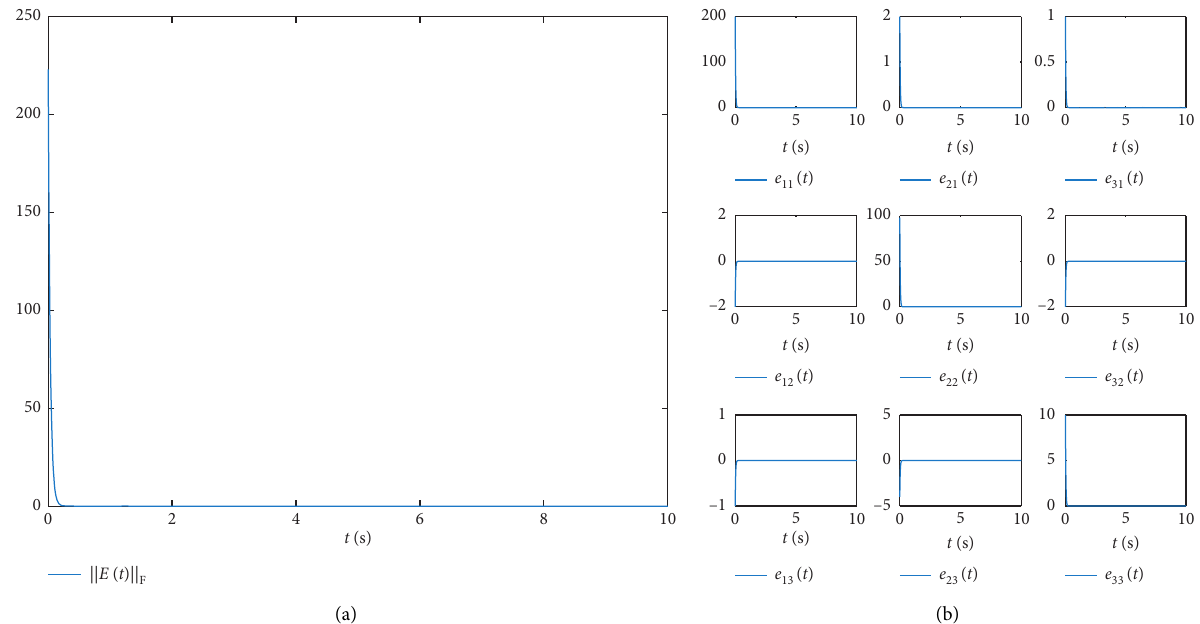
Figure 3: Experiment results synthesized by CTLUD model with λ � 30 and s ( 0 ) � 0 1 0 1 2 3 4 5 6 􏼂 􏼃 T for solving 3-dimensional time-varying LU decomposition problem in Example 2. (a) Frobenius-norm trajectory of error matrix E ( t ) . (b) Trajectories of e e ( t ) , e ( t ) , e ( t ) , e ( t ) , e ( t ) , e ( t ) , and e ( t ) 31 12 22 32 31 23 33